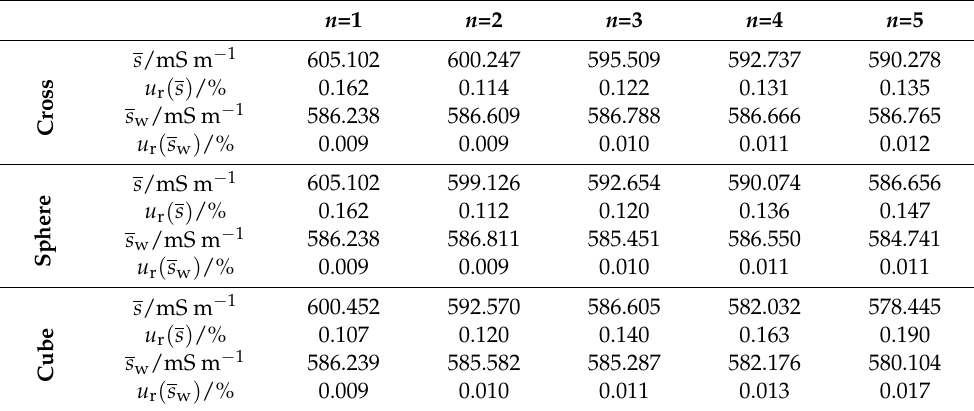
Table 1. Spatial averages of the conductivity estimated with phase-based Helmholtz-EPT under repeatability conditions.